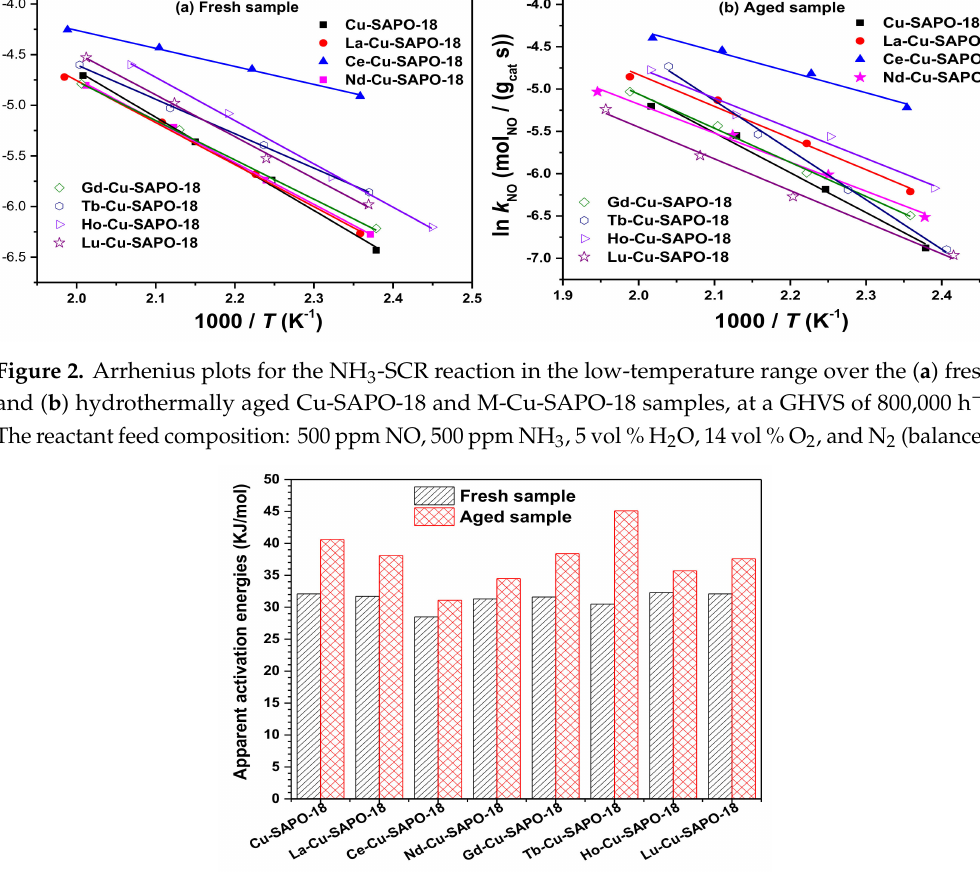
Figure 3. Apparent activation energies for the NH 3 − SCR reaction over the fresh and hydrothermally aged Cu-SAPO-18 and M-Cu-SAPO-18